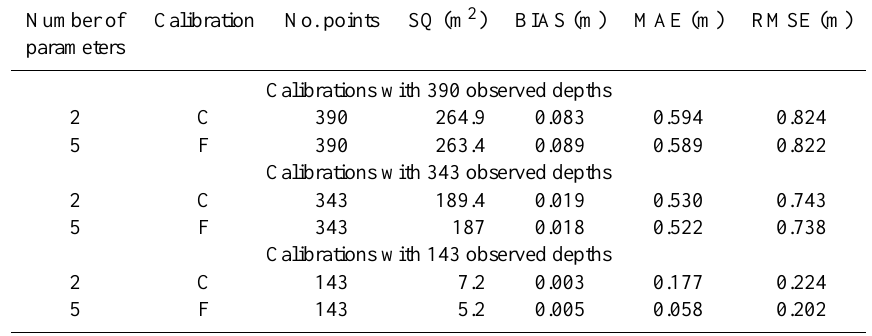
Table 5. Goodness fit criteria of calibrated model results after removing points with low | CV | . Number of